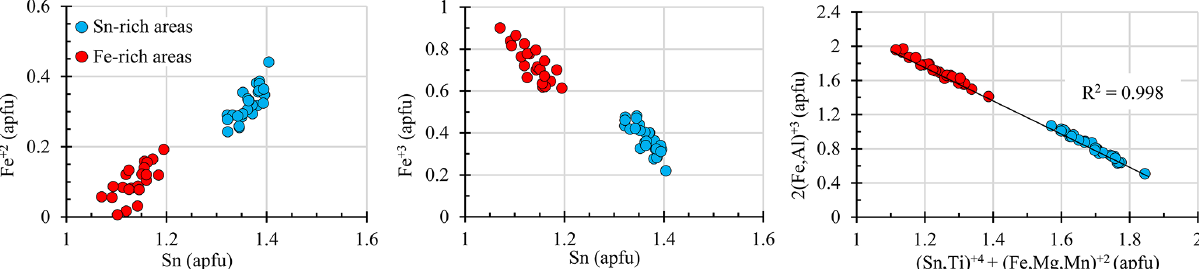
Figure 4. Binary diagrams showing the correlation between elements in atoms per formula unit (apfu) from silesiaite electron microprobe analyses considering Fe + 3 and Fe + 2